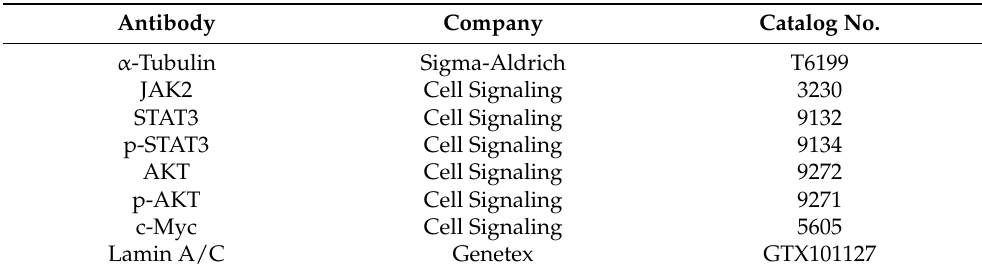
Table 1. Primary antibodies used for Western